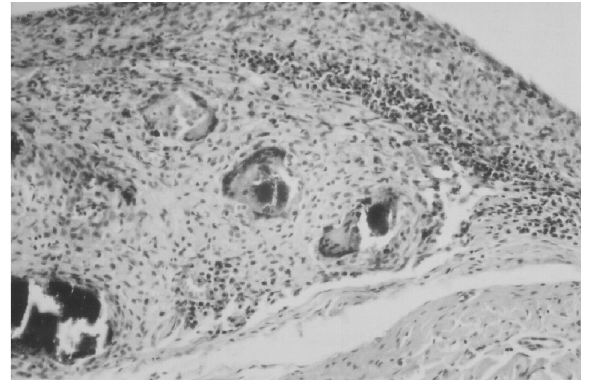
FIGURA 6- Apexit – 7 dias: Infiltrado difuso mononuclear. Reação de corpo estranho mononuclear e gigantocelular. HE Nikon